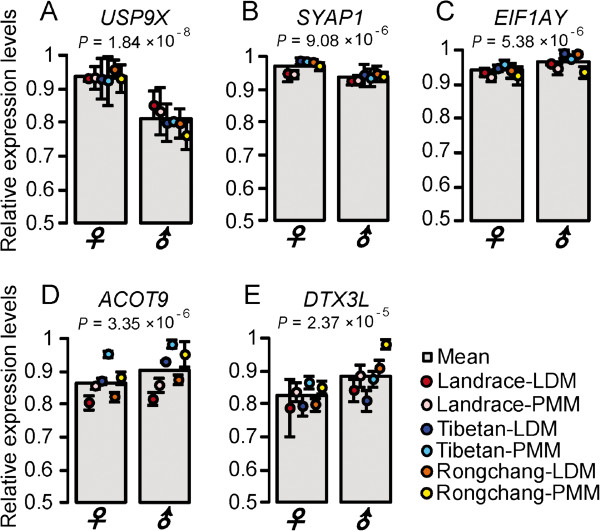
Relative expression levels of sex-specific DEGs. (A)USP9X gene; (B)SYAP1 gene; (C)EIF1AY gene; (D)ACOT9 gene; (E)DTX3L gene. LDM and PMM mean longissimus dorsi muscle and psoas major muscle, respectively. Data are means ± SD. The significance of differences among samples was determined by Student’s t-test.